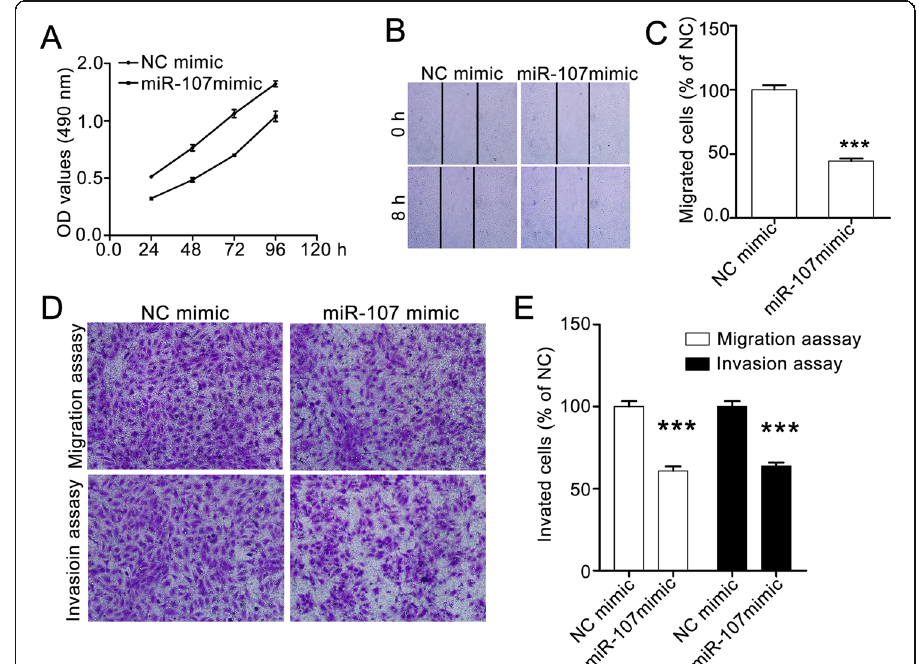
Fig. 2 MiR-107 represses the proliferation, migration and invasion of SW620 cells. a MiR-107 suppresses the proliferation of SW620 cells. The cells were treated with NC mimic or miR-107 mimic for the times shown. Cell viabilities were detected using the MTT assay. b and c MiR-107 inhibits the horizontal migration of SW620 cells. The effect of miR-107 cells on horizontal migration was evaluated with a wound-healing assay. The confluent cells were starved with serum-free medium for 6h and then scratched with 10- μ l pipette tips. After washing with PBS, the cells were treated with or without miR-107 mimic for another 8h. The images were taken at 0h and 8h in the same field with an Olympus IX70 inverted microscope. Representative images (100× magnification) and quantitative data are shown in (b and c), respectively. d and e MiR-107 supresses the vertical migration and invasion abilities of SW620 cells. The effect of miR-107 on vertical migration and invasion was assessed with transwell migration assay and tranwell invasion assay, respectively. Representative images (100× magnification) are shown in D and the quantitative data are shown in E. The data were analyzed with GraphPad Prism 5.0, and are presented as means ± SEM, n=3. *** p <0.001 compared with the control